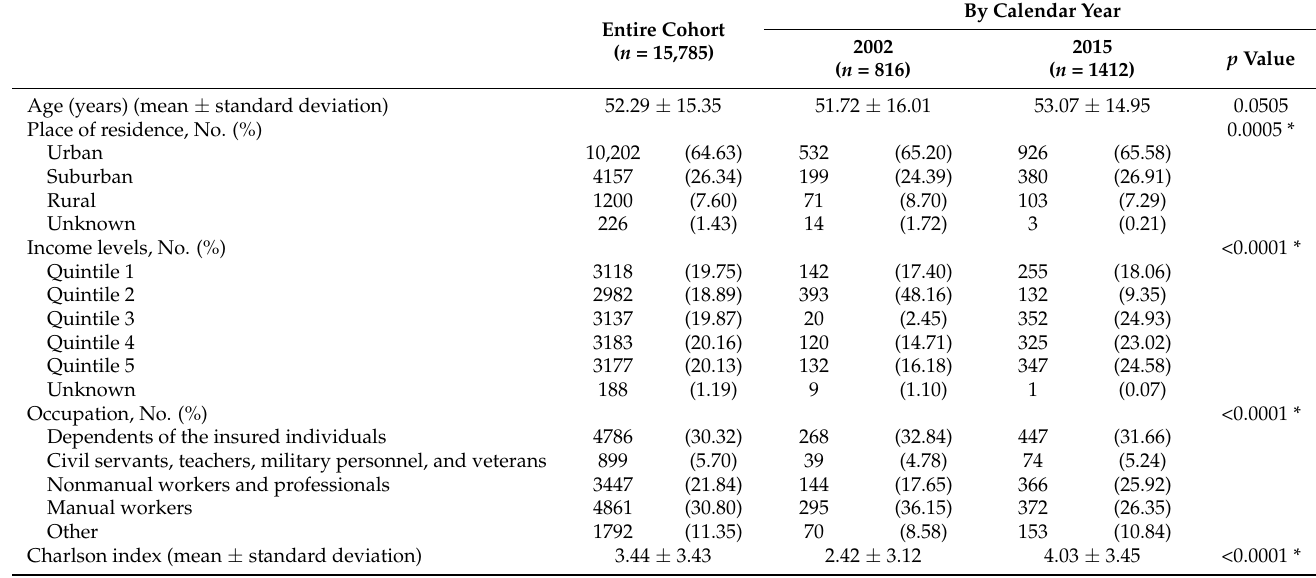
Table 1. Clinical characteristics of ovarian cancer patients in Taiwan from 2002 to 2015.